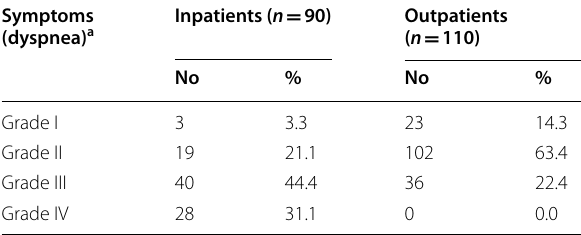
a According to modified medical research council (MMRC) dyspnea